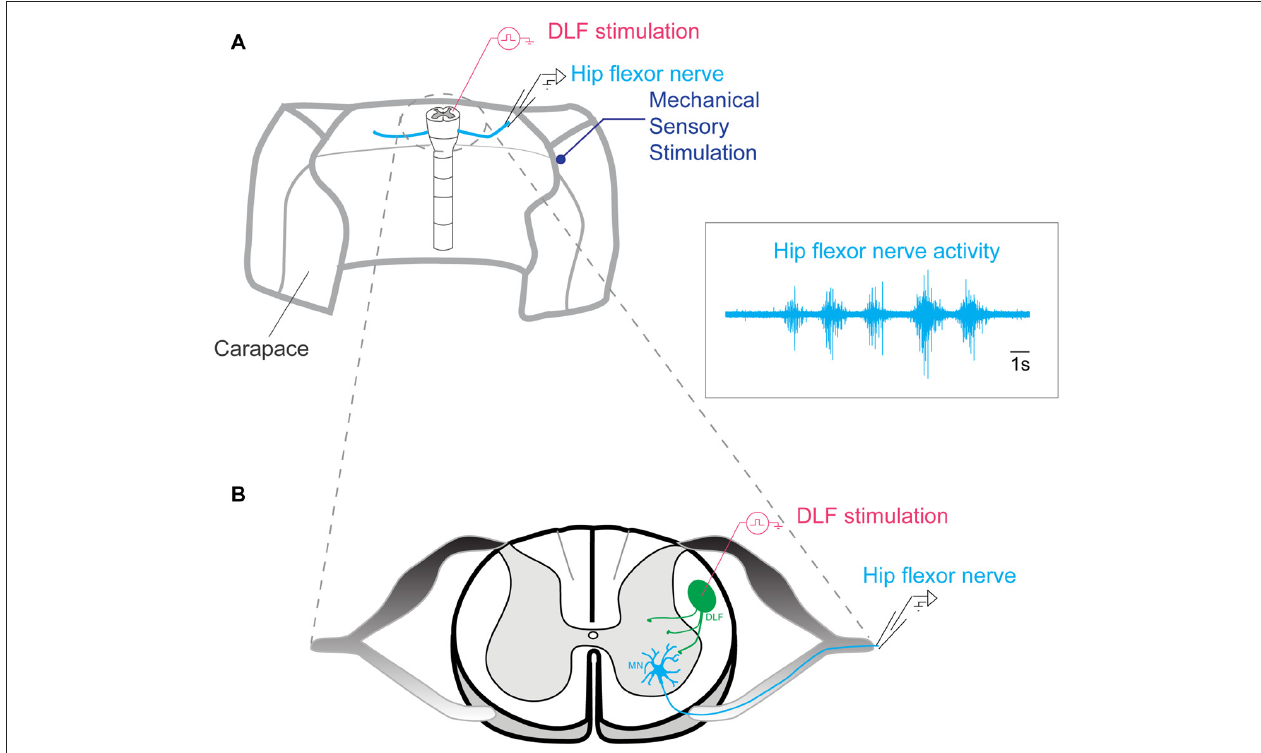
FIGURE 2 | Preparation used for generating scratch behavior. (A) Lumbar segments of the spinal cord left intact in the carapace of an adult turtle. Scratch episodes evoked by mechanical stimulation of the skin were monitored by recording a hip flexor nerve activity with a suction electrode. DLF stimulated by a bipolar electrode. Insert: example of scratch reflex recorded in the hip flexor nerve. (B) Representation of the spinal cord section seen from